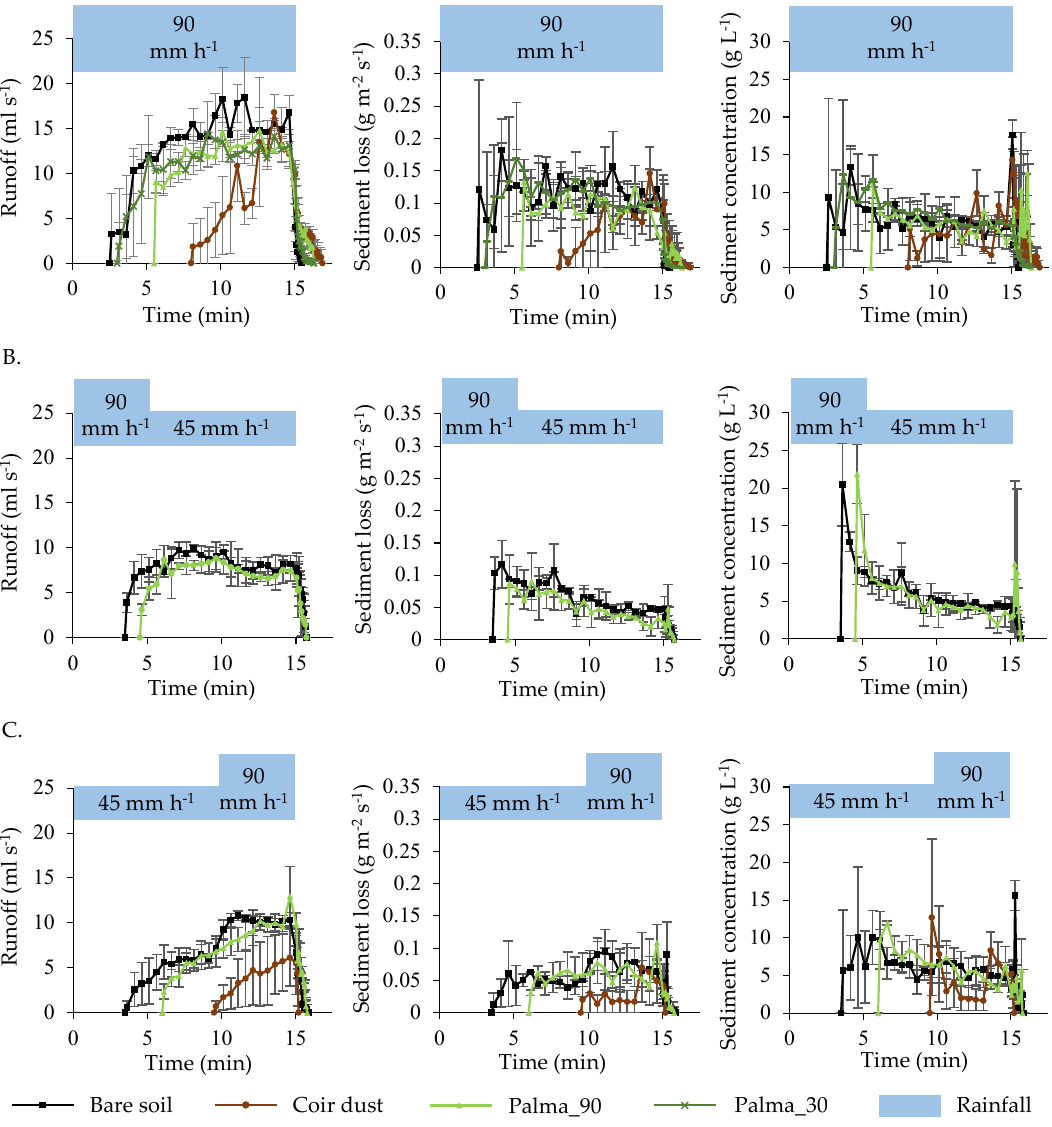
Figure 4. Graphs (mean and standard deviation of three repetitions) of runoff (left), soil loss (center) and sediment concentration (right) observed for all soil cover conditions and for the three rainfall patterns simulated in the experiments: ( A ) Uniform, ( B ) advanced and ( C ) delayed. No runoff and soil loss were observed for the coir dust and advanced rainfall pattern.